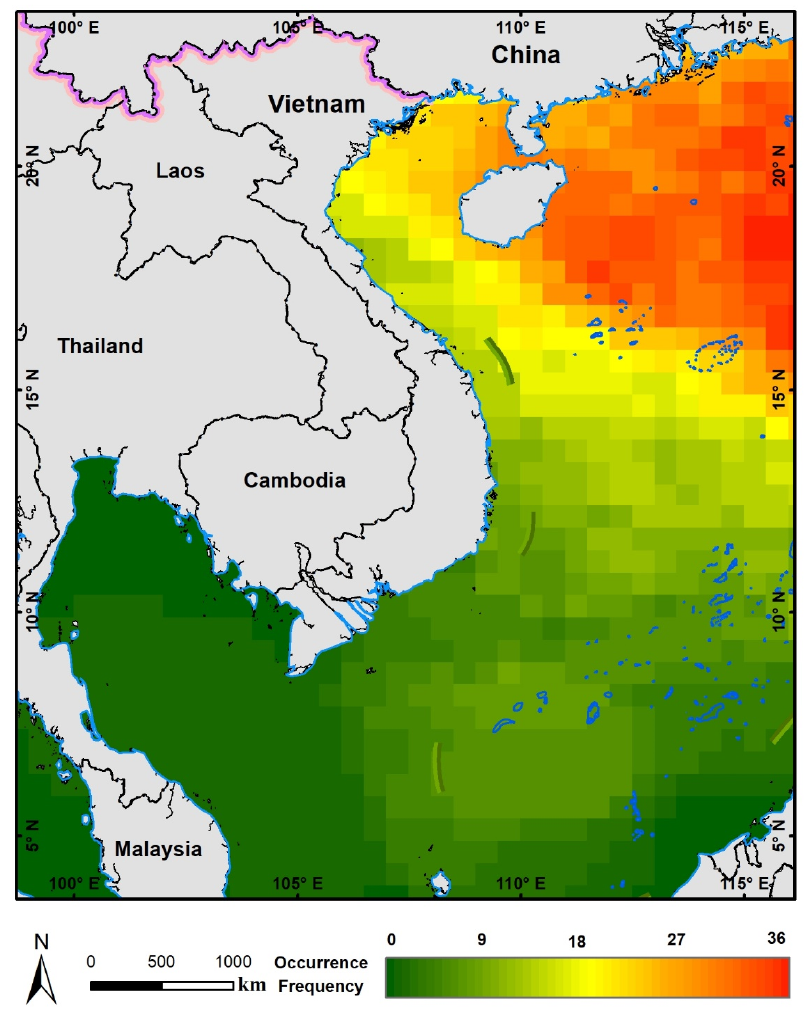
Figure 16. Occurrence frequency of tropical storms in the SCS (2012–2019) in a 0.5° grid. Figure 17 indicates that tropical storms activity varied seasonally in areas A, B and the cyclone-impacted seasons were summer and autumn. It is noted that cyclone-impacted seasons partially coincided with the annual fishery moratorium in area A and the Chinese portion of area B. Accordingly, the Pearson correlation coefficient was computed in the time-series once the summer data was removed. It is evident that seasonal changes of fishing-induced NTL brightness were related to seasonal tropical storm activity in the SCS. A correlation coefficient of −0.9 was obtained for area A, and −0.83 for area B, indi- cating that periodical tropical storm activity strongly suppressed fishing activity in these regions, especially for area A. Although the relationship might be strengthened by incor- porating additional drivers, fishing activity corresponds tightly to tropical storm activity.